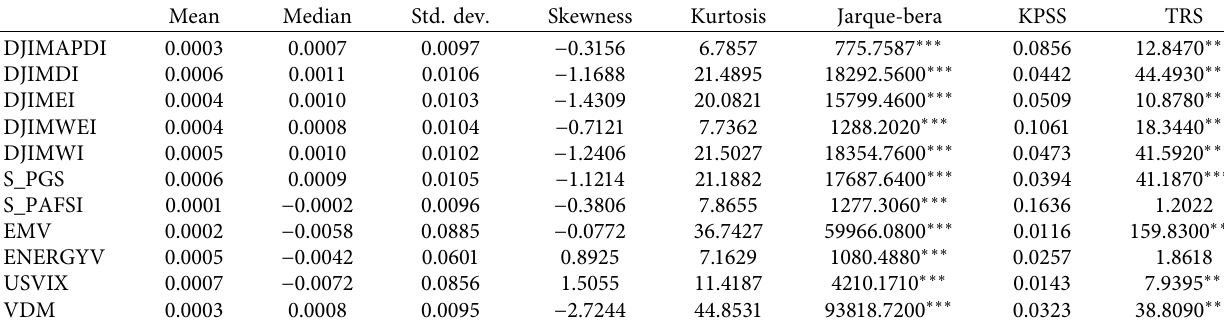
Table 1: Descriptive